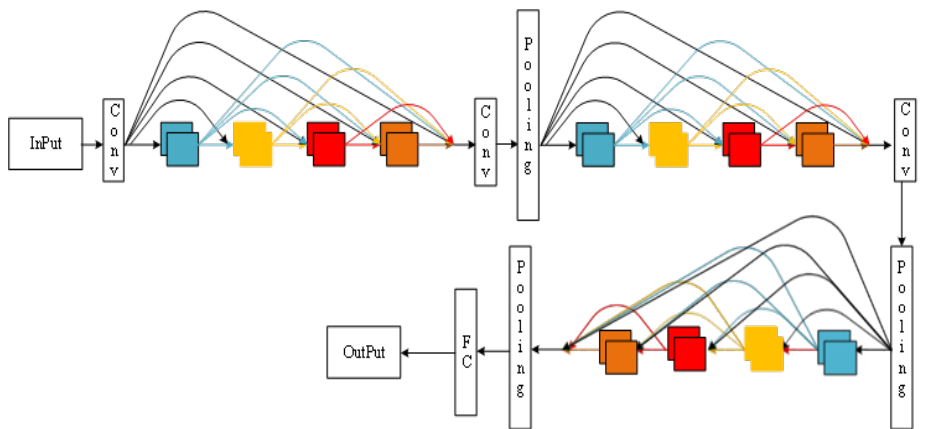
Figure 2. DenseNet network architecture.